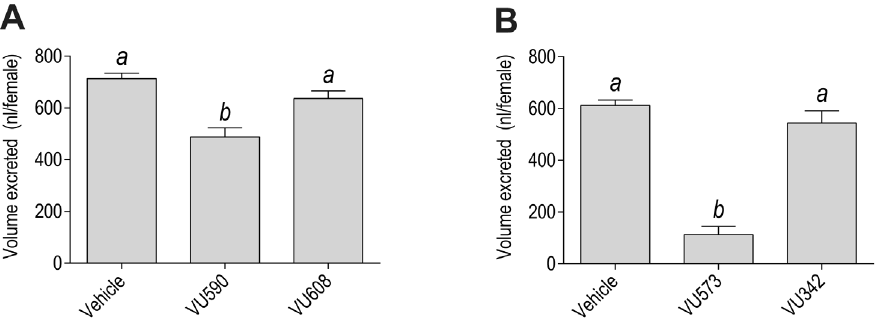
Figure 4. Effects of VU590, VU608, VU573, and VU342 on the in vivo excretory capacity of adult female mosquitoes ( A.aegypti ). (A) Amount of urine excreted by mosquitoes 1 h after injection with 900 nl of the vehicle (K + -PBS 50 containing 1.8% DMSO, 0.077% b -cyclodextrane, and 0.008% Solutol), the vehicle containing VU590 (0.77 mM), or the vehicle containing VU608 (0.77 mM). Values are means 6 SEM; n =11 trials of 5 mosquitoes per treatment. Lower-case letters indicate statistical categorization of the means as determined by a one-way ANOVA with a Newman- Keuls posttest ( P , 0.05). (B) Same as ‘A’, but with VU573 and VU342. n =9 trials of 5 mosquitoes per treatment.